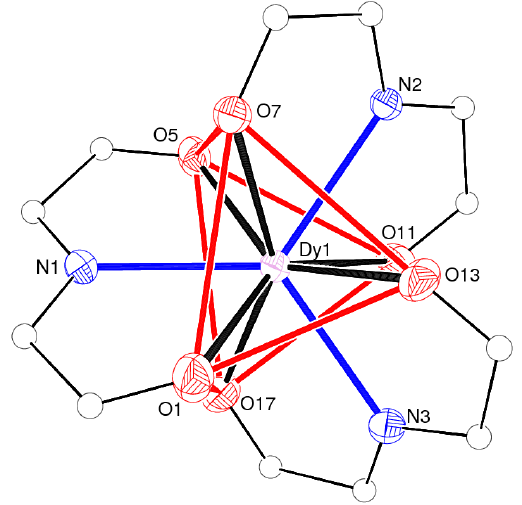
Figure 2. Detail of the structure of 1 showing the tri-capped trigonal prismatic coordination of the Dy 3+ ion (50% displacement ellipsoids, arbitrary spheres for the C atoms). Note the overall, approximate, local C 3 symmetry of these